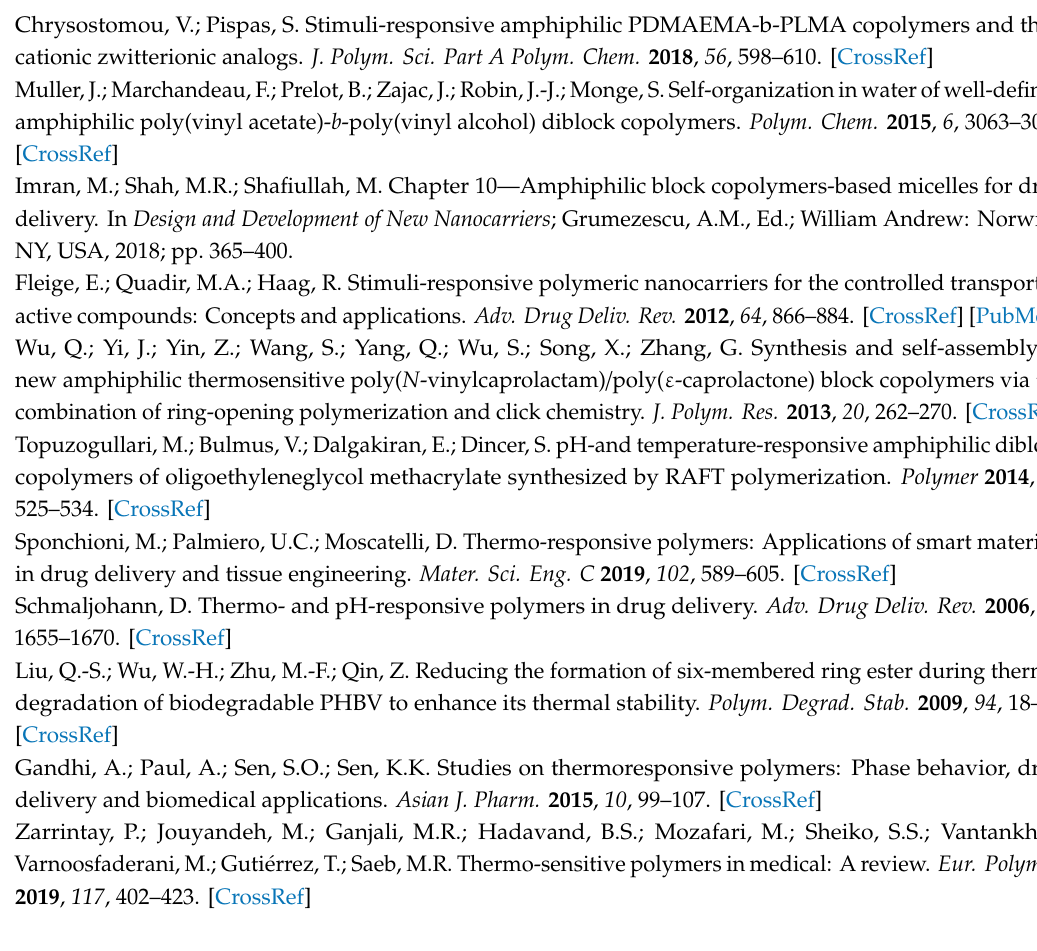
Figure S1: 1 H NMR spectrum of O -ethyl S-4-(hydroxymethyl) benzyl carbonodithioate, Figure S2: (a) Plot of monomer conversion vs. reaction time and (b) plots of the number average molar mass ( M n , filled symbol) and dispersity (Ð, empty symbol) vs. monomer conversion for the polymerization of NVCL in 1.4-dioxane using [NVCL]:[CTA]:[AIBN] = 150:1:0.1 feed molar ratio at 70 ◦ C, Figure S3: 1 H NMR spectra of PNVCL homopolymer before (X-PNVCL–OH, a) and after (PNVCL–OH, b) reaction with AIBN, Figure S4: 1 H NMR spectra of